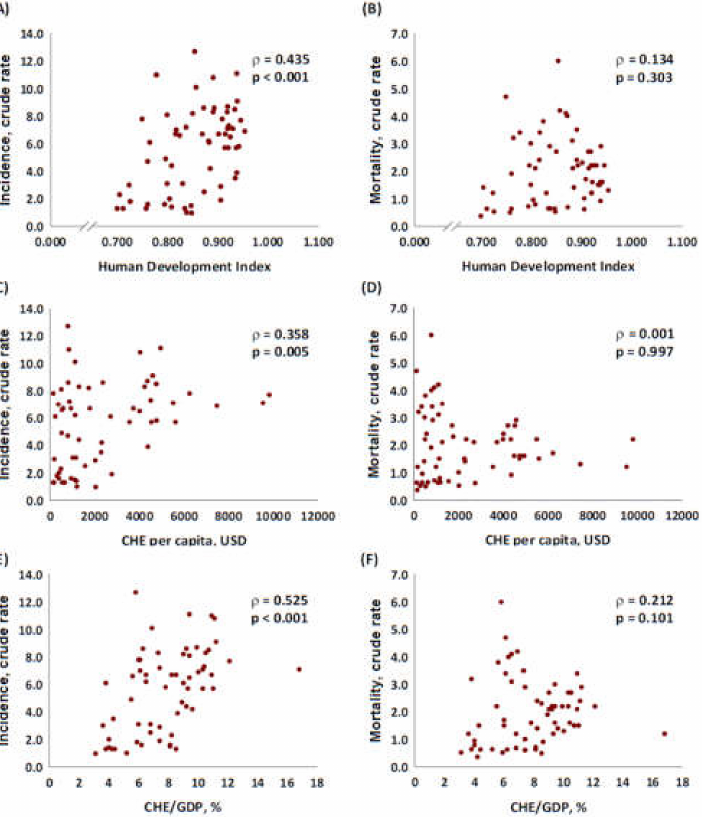
Figure 1. Association between HDI, CHE, and CRs of ( A , C , E ) incidence, and ( B , D , F ) mortality in lip and oral cancer.